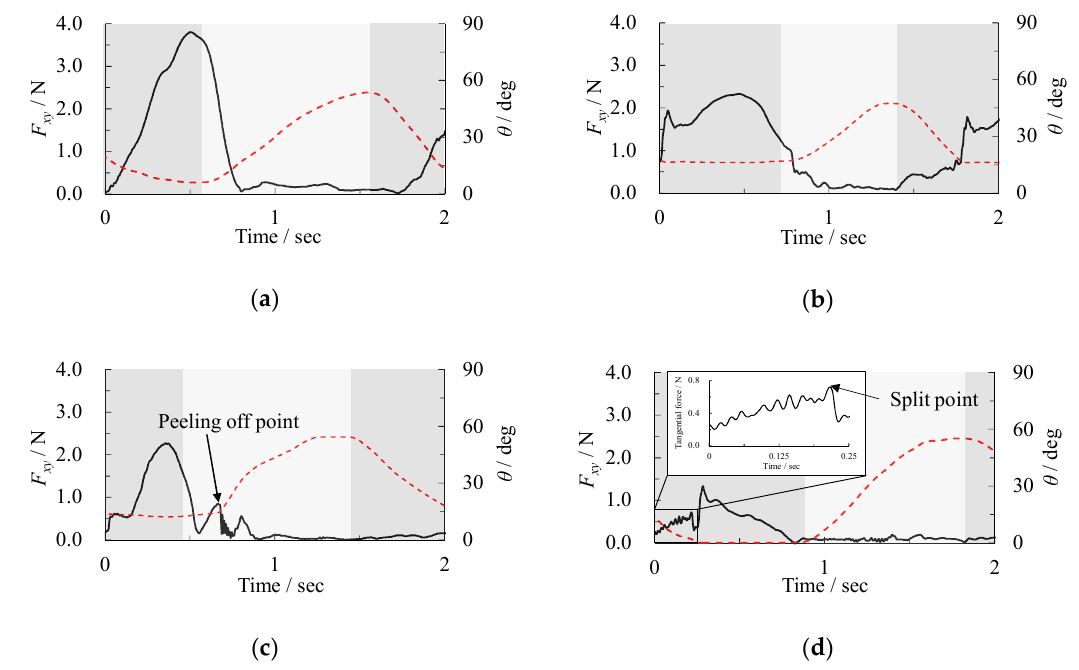
Figure 4. Temporal profiles of tangential resultant force F xy (straight lines) and the angle between the handles θ (dotted-lines) over time as a subject ( a ) grasped the urethane resin (one-step increase pattern), ( b ) the stainless steel plate (two-step increase pattern), ( c ) the adhesive tape (double peak pattern), and ( d ) cut the paper (drastic decrease pattern). Dark gray zones indicate the closing phase and light gray zones indicate the opening phase.